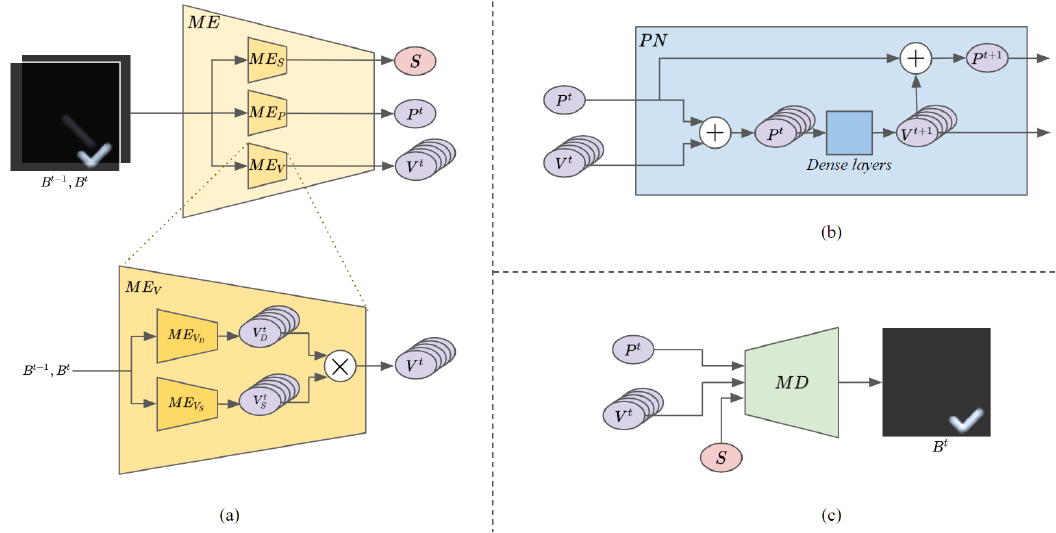
Figure 4. Overview of model details: ( a ) motion encoder; ( b ) prediction network; ( c ) motion